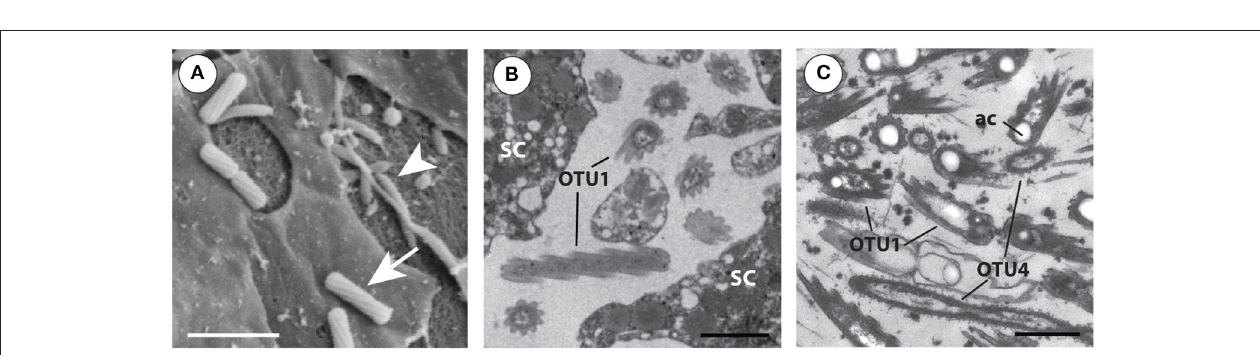
FIGURE 4 | Fluorescent in situ hybridization (FISH) of the primary Amphimedon queenslandica symbiont (OTU 1) in microbe-enriched cell preparations from adult sponges. (A) SEM of the cell preparation used for the FISH experiments, showing the abundance of the OTU 1 bacterial morphology (false colored in red). Scale bar 5 µ m. (B) FISH on bacterial-enriched cells using Cy3-labeled-OTU 1-specific probe (red; arrow), complemented by DAPI that labels all bacterial cells (blue; non-OTU 1-labeled cells, arrowhead). Scale bar 20 µ m. (C) Negative control using reverse complement OTU 1-specific probe, with DAPI labeling all bacteria (blue). Scale bar 20 µ m.